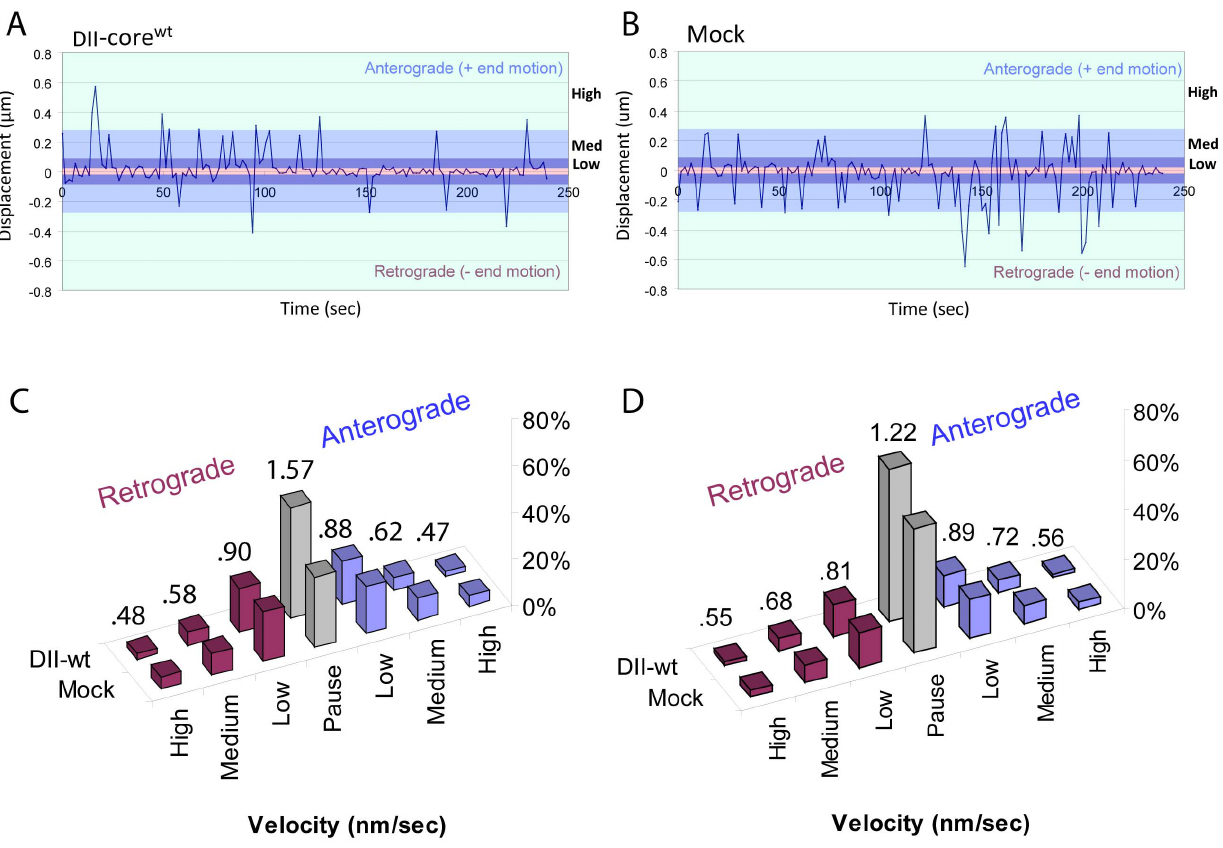
Figure 4. DII-core wt coated LD velocities measured in naı¨ve Huh-7 cells and Huh-7 cells stably expressing an HCV subgenomic replicon. (A–B) Average representative measurement of a much larger data set, LD velocities in retrograde or anterograde directed transport are measured in Huh-7 cells expressing (A) DII-core wt and (B) mock transfected. The velocity amplitudes at each time point are divided into parameters of, low, medium, and high velocities for both directions. The pink parameter line is indicated by a paused event, which was determined by obtaining the average speed of LDs from nocadazole treated Huh-7 cells. (C–D) The frequency of low (15.7 nm/sec –50 nm/sec), medium (50.1 nm/sec –180 nm/ sec), and high velocity ( . 180.1 nm/sec) measurements, expressed as a percentage, in both directions, are plotted after particle tracking LDs in DII- core wt expressing (C) Huh-7 cells, and (D) Huh-7 cells harbouring an HCV subgenomic replicon. The velocities are measured for DII-core wt coated LDs in DII-core wt expressing cells, and LDs from mock cells not expressing DII-core wt . The ratios above each set of columns are calculated by dividing the frequency for each velocity interval of DII-core wt coated LDs by their respective mock LDs.